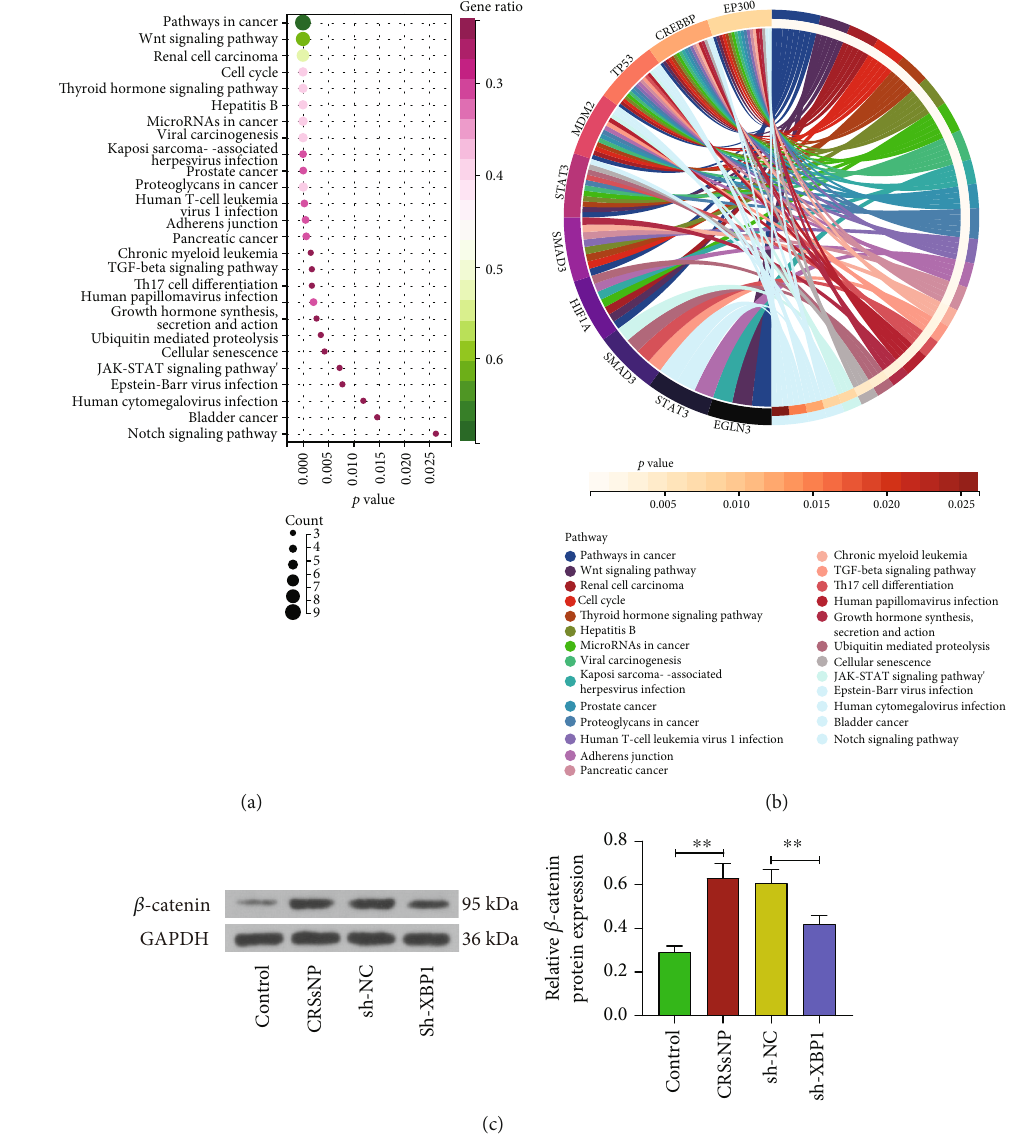
Figure 4: Silencing of HIF-1a inhibits the Wnt/ β -catenin pathway. (a) KEGG enrichment analysis of genes associated with HIF-1a and (b) visualization by bubble mapping. (c) Western blot detection of protein expression of β -catenin in nasal mucosal tissues of CRSsNP mice. ∗∗ p < 0 : 01 versus the control mice or CRSsNP mice administrated with sh-NC. The data are measurement data, presented as mean ± SD . Data among multiple groups were compared using one-way analysis of variance and then analyzed with Tukey ’ s post hoc test. The experiment was independently repeated three times. n = 6